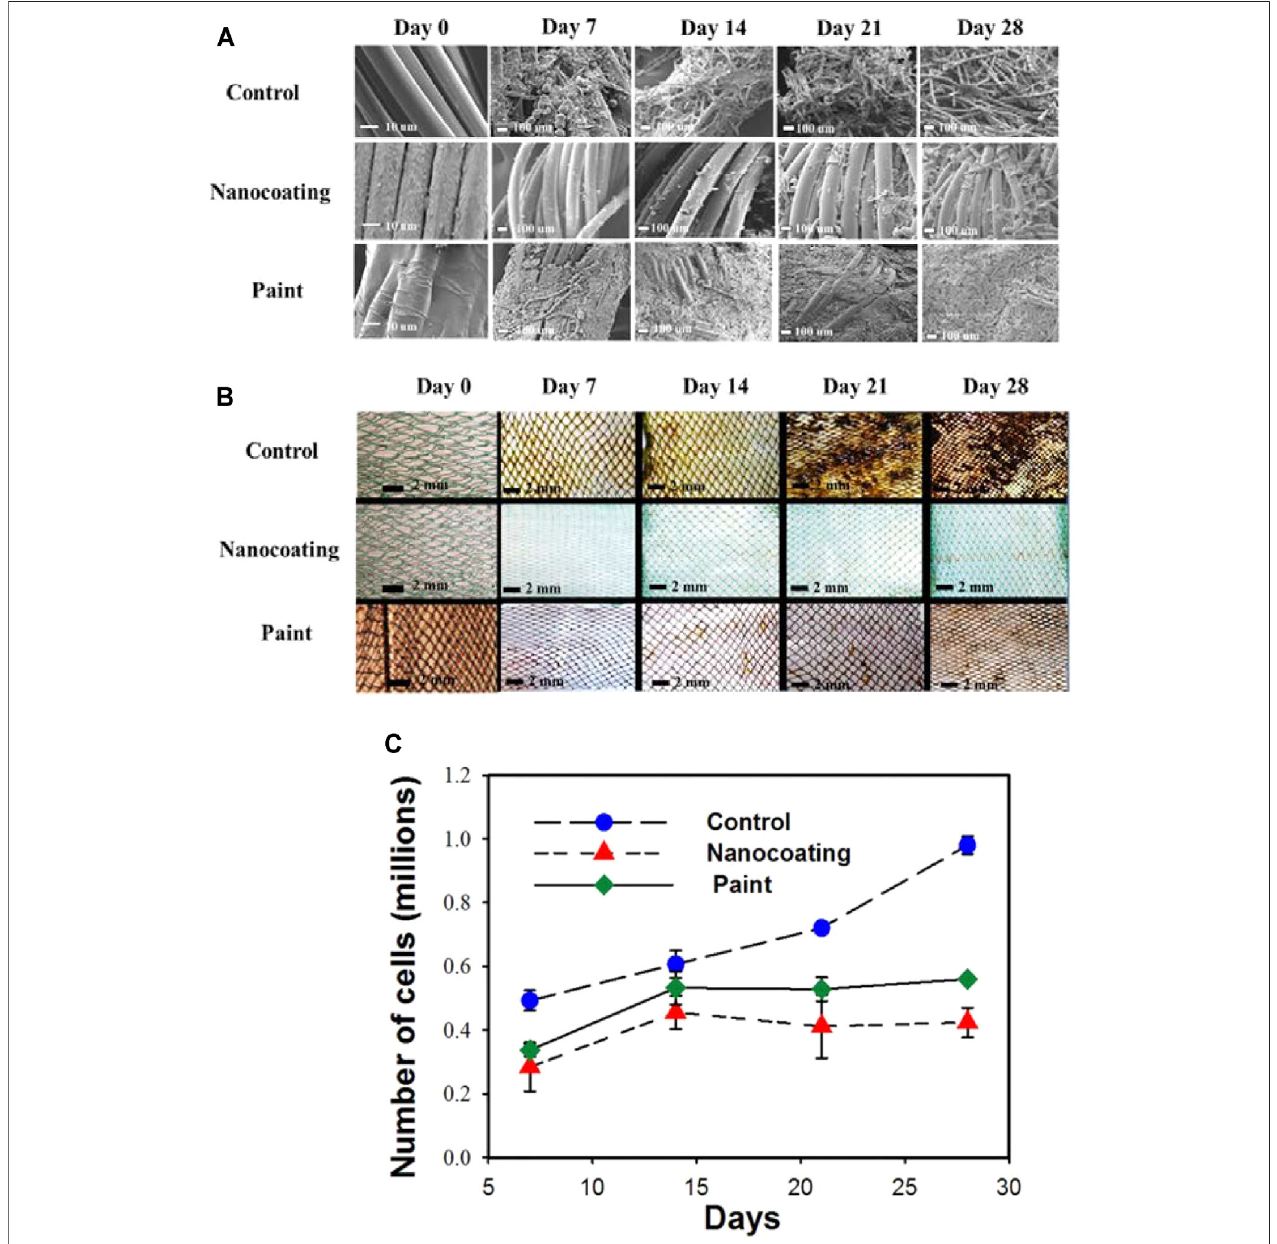
FIGURE8| Totalmicrobialprofusionandsurfacecoverageofthecontrol,ZnOnanocoatingandcopper-basedantifoulingpaintcoatednetsubstrates (A) scanning electron micrographs (B) optical micrographs, and (C) population count. Reproduced with permission from (Sathe et al., 2017).